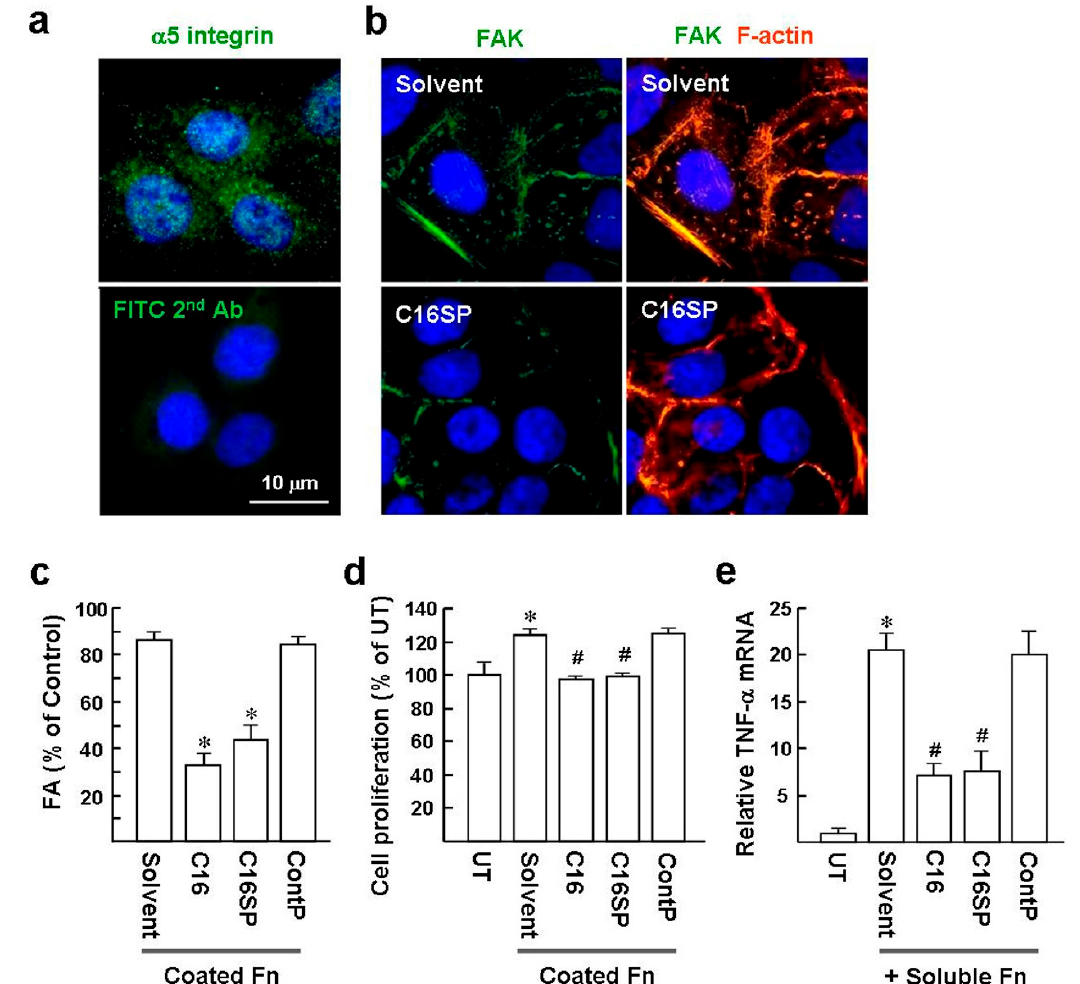
Figure 1. C16 peptide blocks α 5 β 1 integrin-induced cellular responses in HaCat cells. ( a ) Immunofluorescence staining of α 5 integrin. Representative images of three independent experiments. Nuclei were visualized with Hoechst 33258 stain. Original magnification, × 1000. NC: Immunofluorescence staining with FITC-conjugated secondary antibody alone. ( b ) Immunofluorescence staining. Subconfluent HaCat cells were plated on Fn-coated coverslips and incubated in low-serum medium (2% FBS) for 16 h prior to treat with 10 µ M C16SP or solvent for a further 3 h. Representative images of three independent experiments show focal adhesion kinase (FAK) and stress fiber (TRITC-phalloidin staining). ( c ) The percentages of HaCat cells with marked FAK-positive focal adhesions (FA), per total cells, were calculated from 10 randomly selected microscopic fields in each treatment. Results are expressed as mean ± SD of three independent experiments. * p < 0.0001 versus solvent-treated cells. ( d ) E ff ect of the C16 on HaCat cell proliferation. Cell culture and treatment are described in the Methods. The proliferation index of each treatment was compared with the cells cultured on plates without Fn-coating (untreated; set as 100%). * p < 0.03 versus untreated (UT; Fn-uncoated and medium containing 2% FBS). # p < 0.004 versus solvent-treated cells. ( e ) 2 × 10 5 HaCat cells were incubated in serum-free medium for 16 h, and then treated with Fn (5 µ g / mL) and 10 µ M peptide in fresh serum-free medium for another 3 h. Real-time qPCR analysis was conducted to determine the TNF- α mRNA * p < 0.0003 versus untreated cells. * p < 0.001 versus solvent / Fn-treated cells.